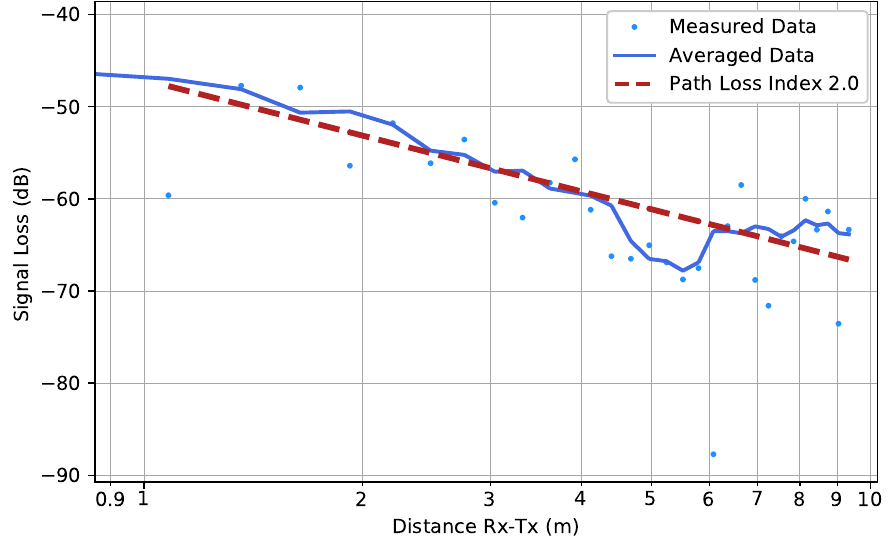
Figure 14. Scenario ST2: The measured data together with their averaged values ( solid line ) according to Equation (3). The fitted path loss line is also shown ( dashed line